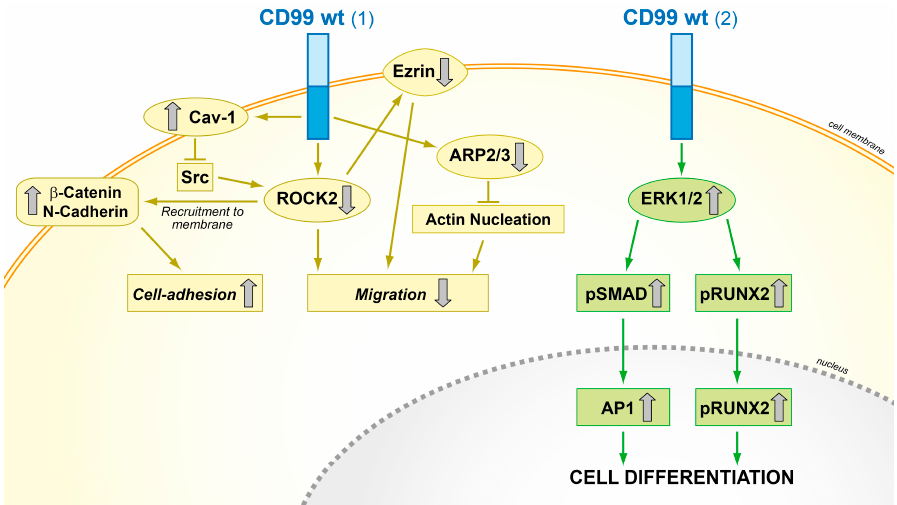
Figure 5. Schematic representation of the functional effects of forced CD99 expression in osteosarcoma cells. (1) CD99wt inhibits the c-Src/ROCK2 axis, which leads to ezrin inhibition, N-cadherin and β -catenin recruitment to the plasma membrane, and ARP2/3 downregulation, thereby increasing cell adhesion and reducing migration; (2) CD99wt upregulates ERK1/2 signaling and promotes the activity of the main osteogenic transcriptional factors AP1 and RUNX2, which in turn reactivate terminal differentiation [18,48,55].